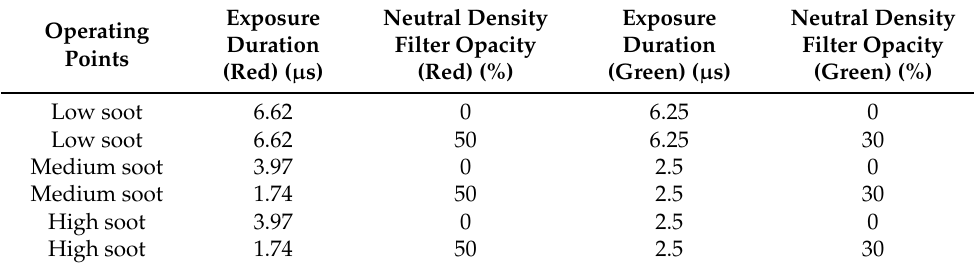
Table 4. Dynamic range influence test